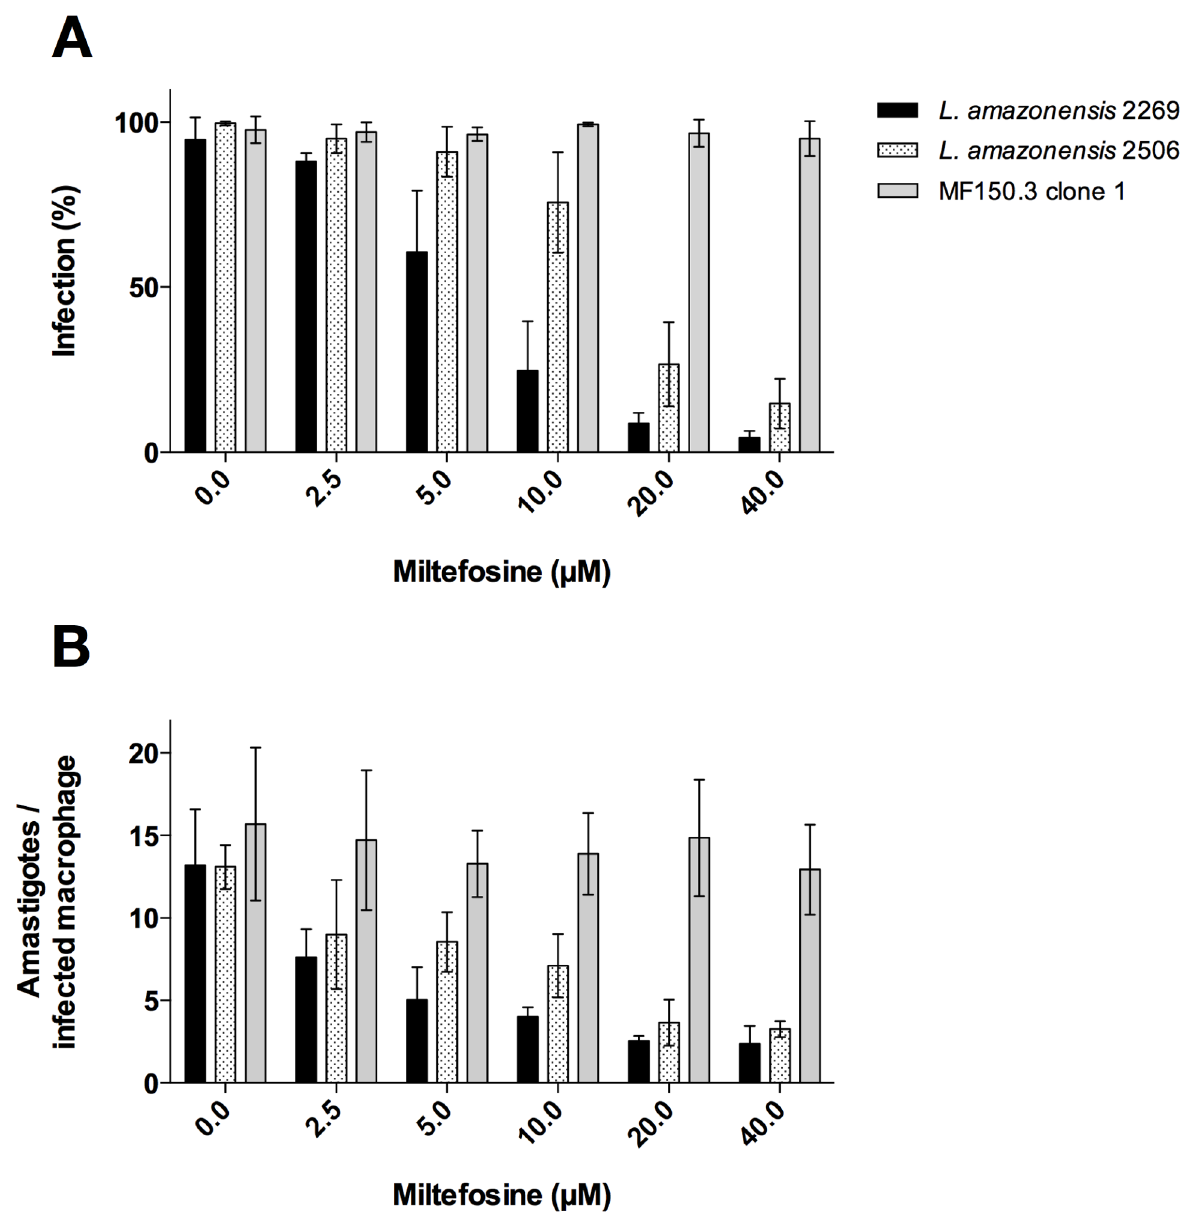
Figure 2. Activity of MF against intracellular amastigotes of L. amazonensis . (A) MF susceptibilitiy of intracellular amastigotes of L. amazonensis wild-type parasites M2269 and 2506 and mutant MF150.3-1. The percentage of infection was determined by counting 100 cells/ coverslip and bars represent percentage of infected BMDM in different concentrations of MF as indicated. The average 6 standard deviation of three independent experiments is shown. (B) Number of amastigotes per infected macrophage treated with different concentrations of MF (2,5–40 m M). Macrophages were infected with a ratio of 20 parasites per macrophage.